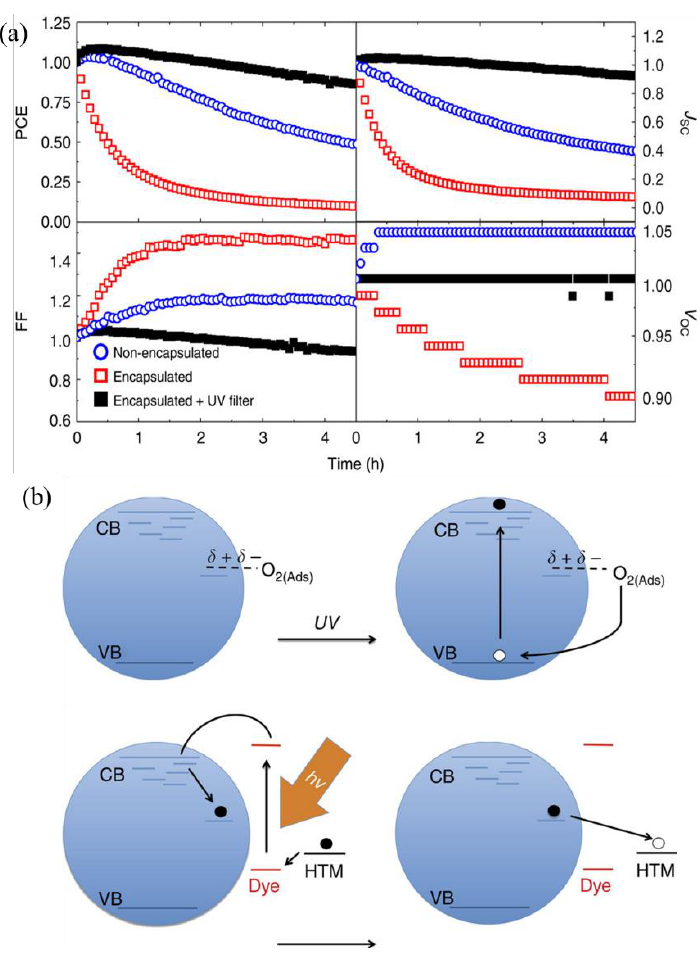
Figure 5. ( a ) The evolution of performance parameters measured in different conditions and ( b ) degradation mechanism against UV light. Reprinted with permission from reference